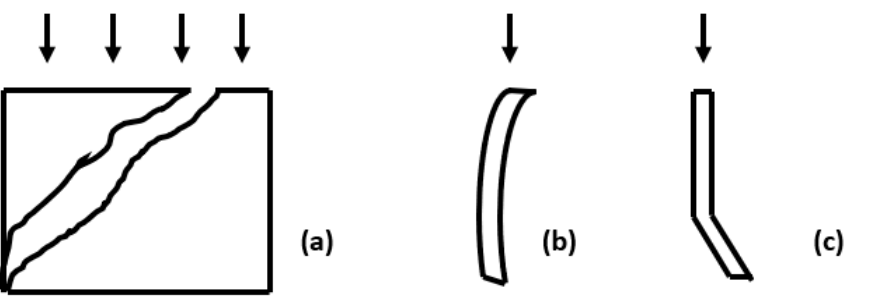
Figure 3. Schematic representation of failure modes/mechanisms commonly reported in the literature: ( a ) diagonal shear failure along the 45° direction, ( b ) elastic buckling, and ( c ) inelastic buckling.